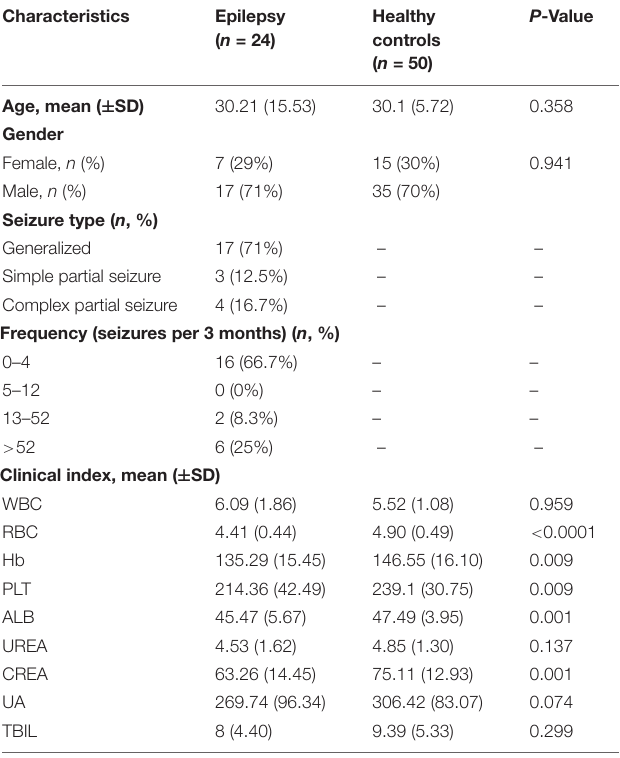
TABLE 1 | Characteristics of the participants in this study.